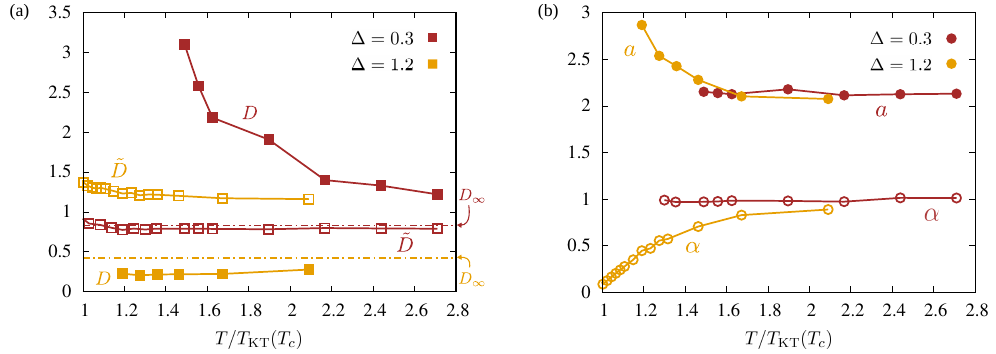
Figure 8: Temperature dependence of diffusion constant: The diffusion coefficient is extracted from the fit κ ( q ) = Dq a over a range at high temperatures. We plot in (a) D (solid squares), and in (b) the exponent a (solid circles), as a function of temperature. In (a), we show the comparison of diffusion constant D ( T ) calculated / 4 λ from dynamical structure factor with ˜ D = v 2 (open squares) extracted from L B Fig.3 for ∆ = 0.3 and ∆ = 1.2. Horizontal dashed-dot lines represent the asymptotic infinite temperature values of D ∞ at these two anisotropies. D ∞ (cid:39) ˜ D ∞ ( ≈ 0.8, not shown) for easy-plane case whereas D ∞ ≈ 0.42 and ˜ D ∞ ≈ 1.14 (not shown) for easy-axis case. (b) shows that the deviation of the exponent a from the diffusive value ∼ 2 starts exactly where the auto-correlation exponent α (open circles) deviates away from ∼ 1 (Fig.6). Note that for simplicity of notation, we refer to D as diffusion constant even when a deviates substantially from the diffusive value